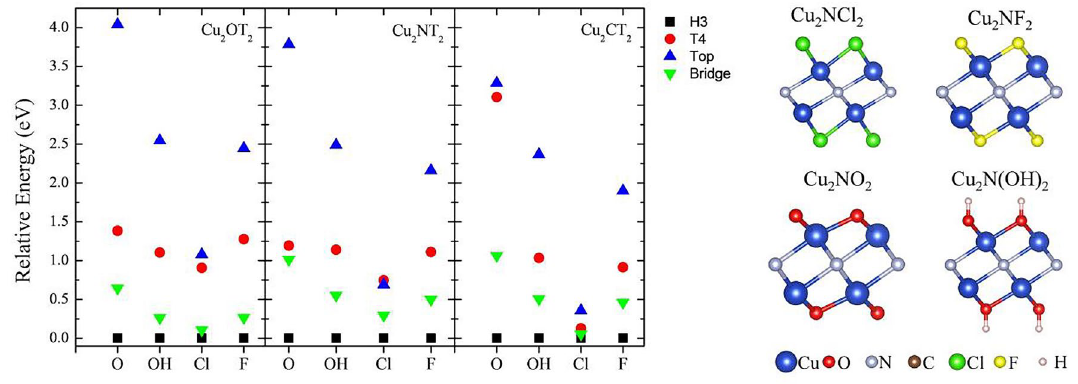
Figure 4. Relative energies for the different Cu 2 XT 2 (X = O, C, N and T = Cl, F, O, OH), the atomistic model for the Cu 2 NT 2 are